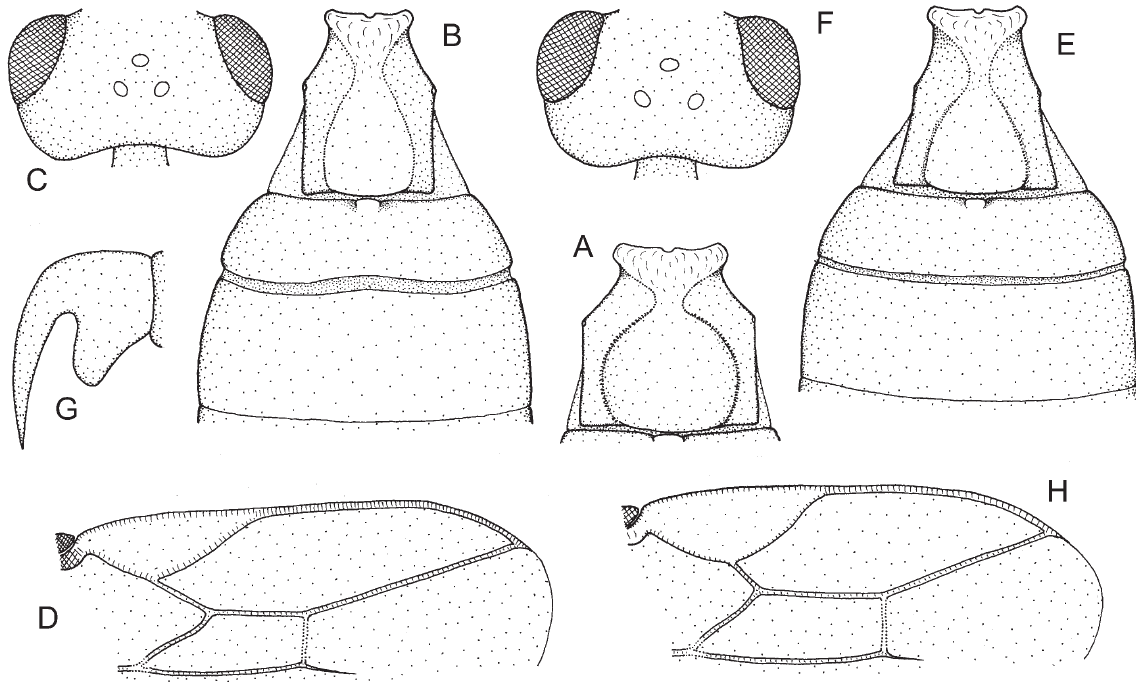
Fig. 4. — A . Bracon ( Glabrobracon ) dichromus Wesmael, 1838, first tergite of ♀. — B-D . Bracon ( Glabrobracon ) helleni Telenga, 1936, ♀. B . Tergites 1-3. C . Head in dorsal view. D . Distal part of right forewing. — E-H . Bracon ( Glabrobracon ) popovi Telenga, 1936, ♀. E . Tergites 1-3. F . Head in dorsal view. G . Claw. H . Distal part of right